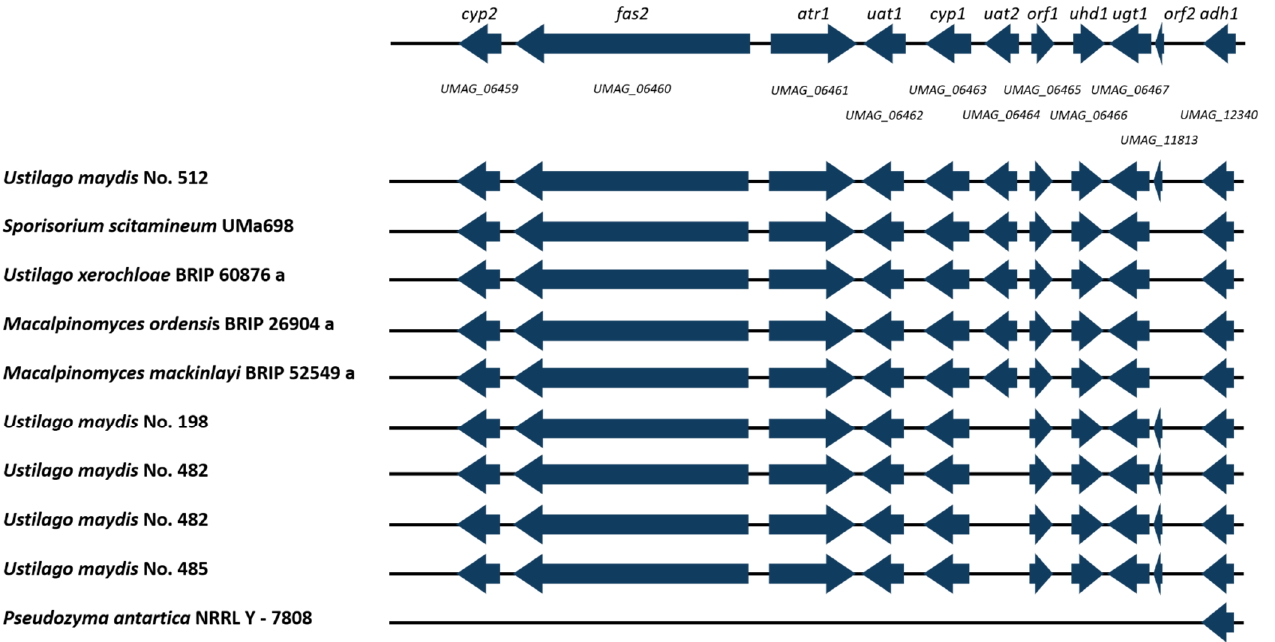
Figure 8. Schematic organization of the ustilagic acid (UA) synthesis gene cluster in U. maydis (modified from [65]). Organization of the gene cluster is compared to the here sequenced Ustilaginaceae. Cyp2 (P450 monooxygenase), fas2 (fatty acid synthase 2), atr1 (ABC-type transporter), uat1 (acyltransferase), cyp1 (P450 monooxygenase), uat2 (acetyltransferase), orf1 (alcohol acetyltransferase), uhd1 (fatty acid hydroxylase), ugt1 (glycosyltransferase), orf2 (ustilagic acid biosynthesis cluster protein), adh1 (alcohol dehydrogenase I). Gene cluster analysis via antiSMASH 6.0 [58]. Two isolates were sequenced in case of U. maydis No. 482.